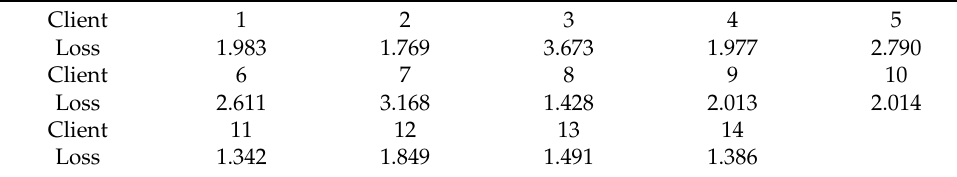
Table 3. Loss values for each local model.